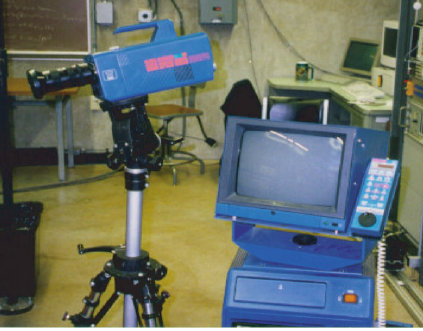
Figure 4: View of the high-speed video camera system.